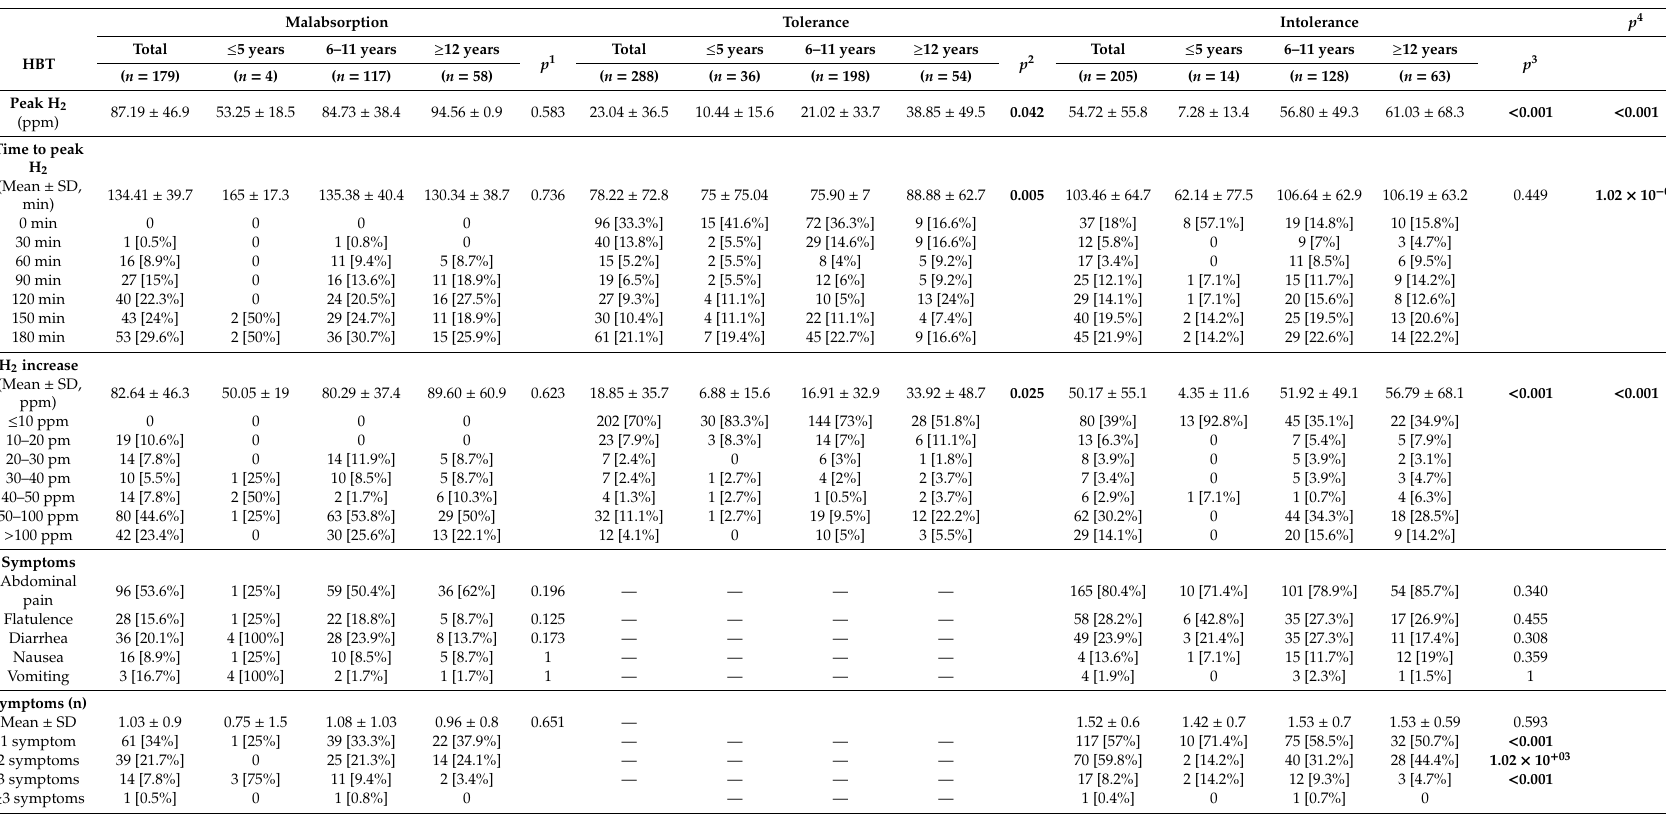
Table 2. Comparison of HBT results and induced symptoms in children with lactose malabsorption, tolerance, and intolerance, stratified according to age. Malabsorption Tolerance Intolerance p